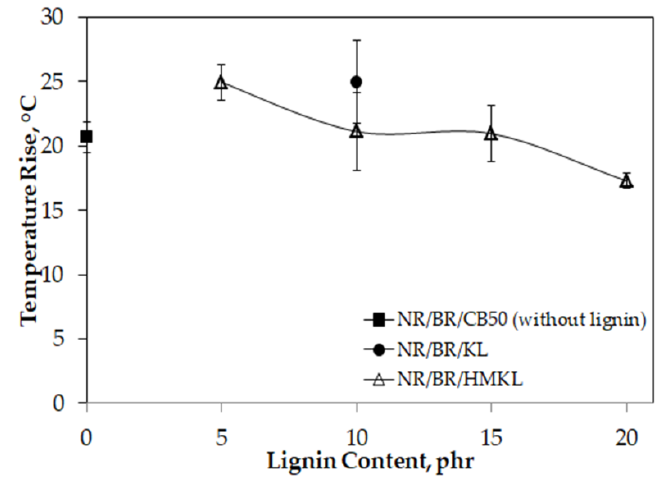
Figure 13. The effect of HMKL content on the heat build-up in lignin-filled NR/BR compounds.